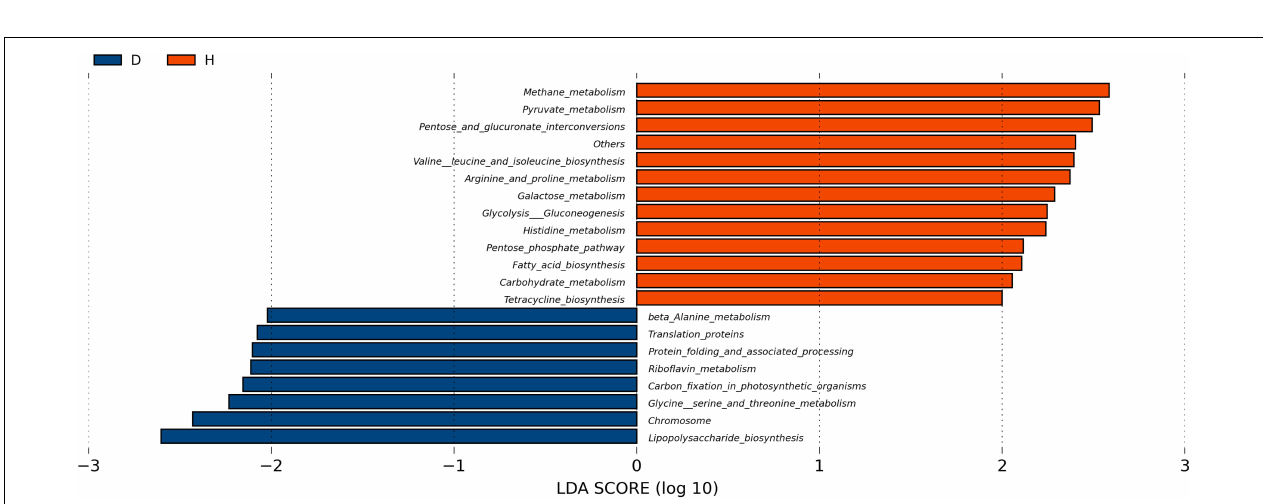
Frontiers in Microbiology |